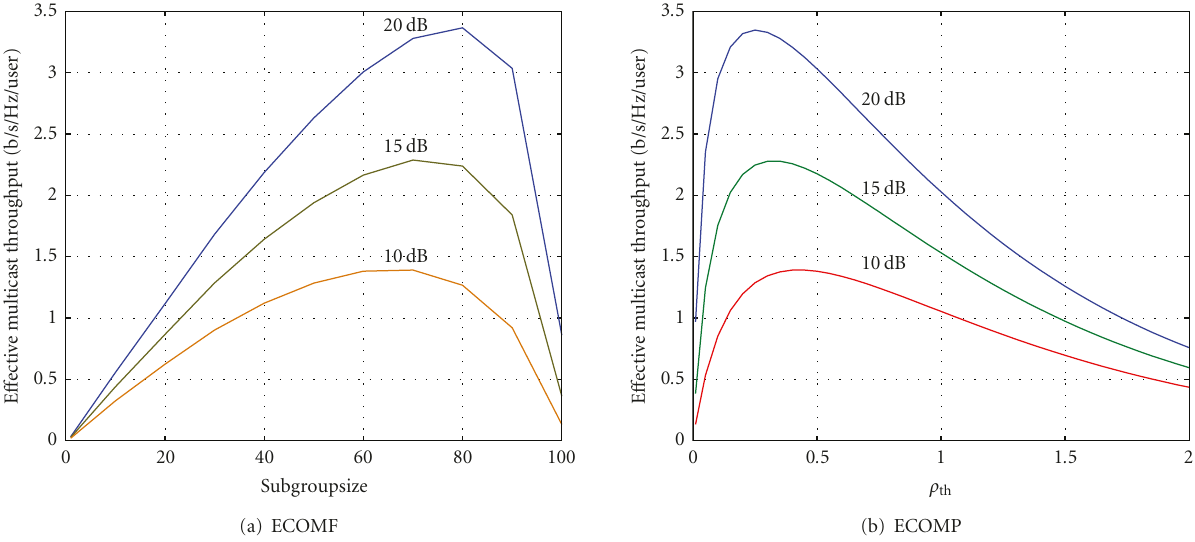
Figure 3: Optimal e ff ective multicast throughputs of ECOMF and ECOMP in a Rayleigh fading channel for di ff erent average SNRs.